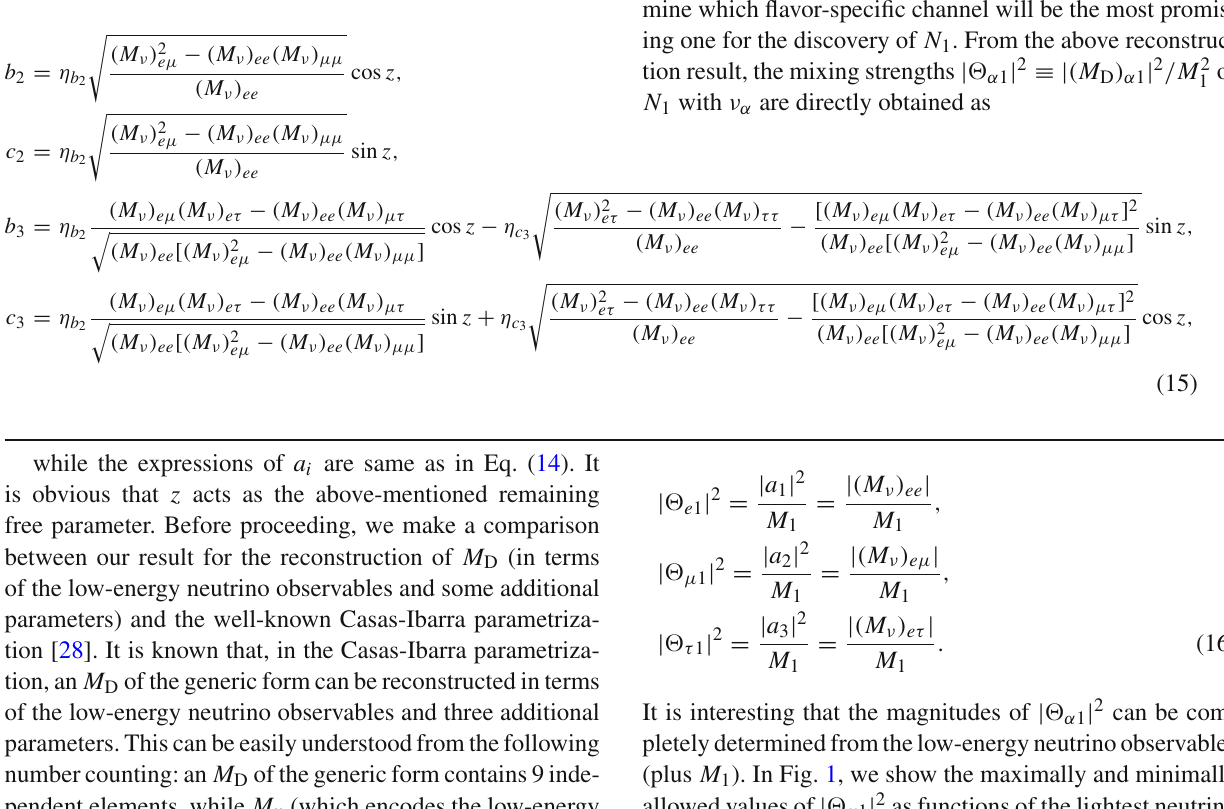
values of the lepton flavor mixing angles and neutrino mass squared differences as typical inputs, and allowing the CP phases to vary in their whole ranges